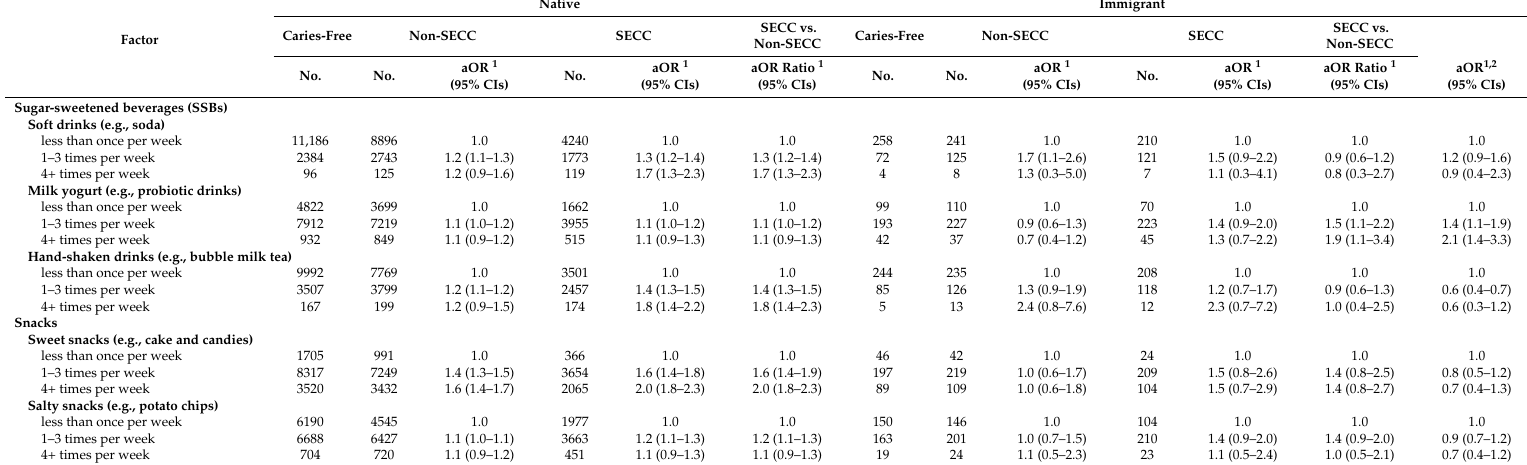
Table 3. Adjusted odds ratios of dental caries status associated with sugar-sweetened beverages and snacks intake in native and immigrant